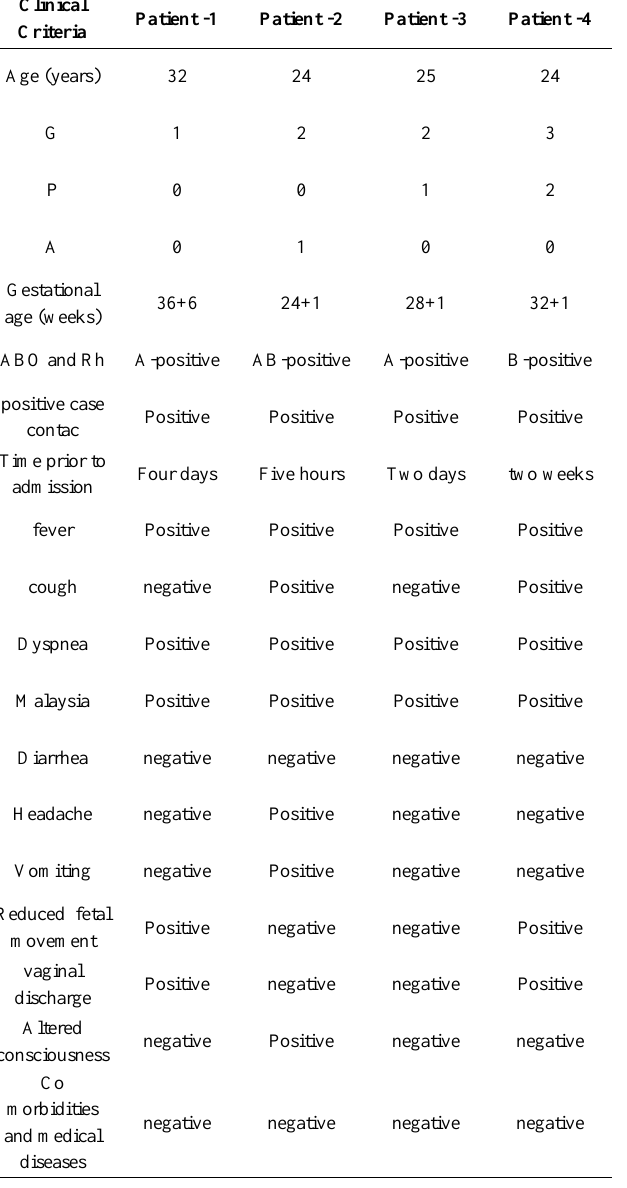
The demographic data and symptomatology of the cases. Clinical